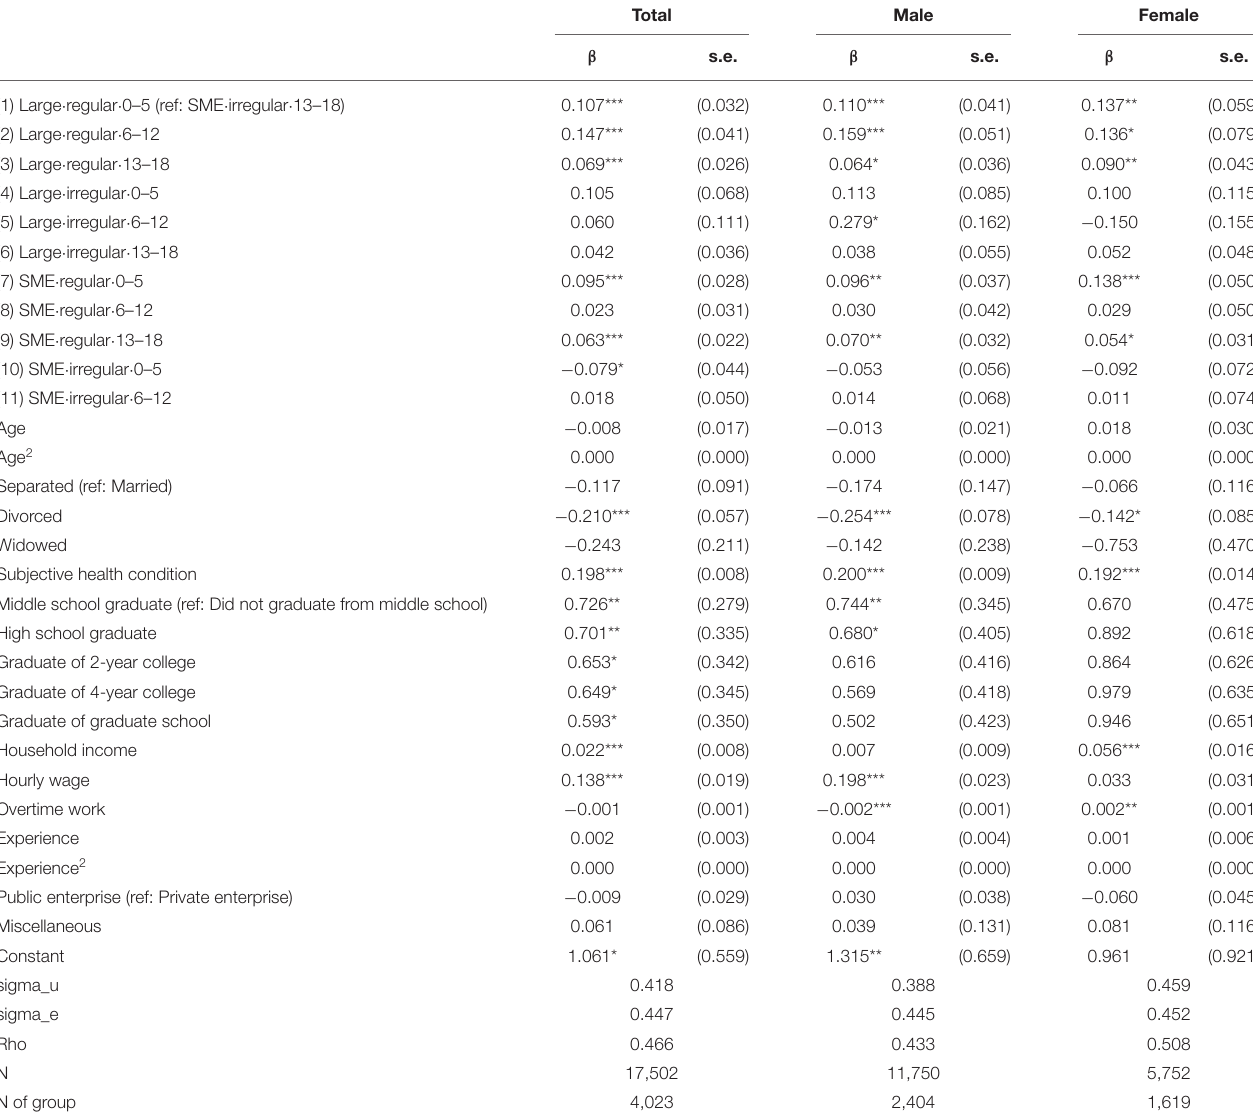
TABLE 5 | Effects of children’s age on life satisfaction by stratified labor market group